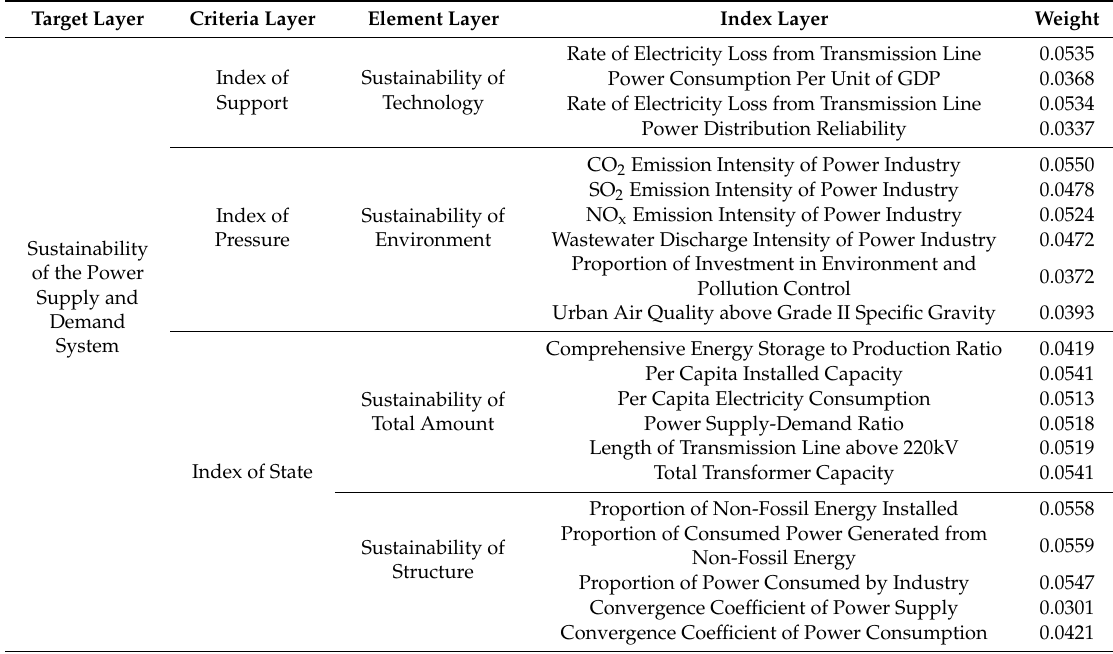
Table 5. Index weights of the sustainability evaluation system of the power supply and demand